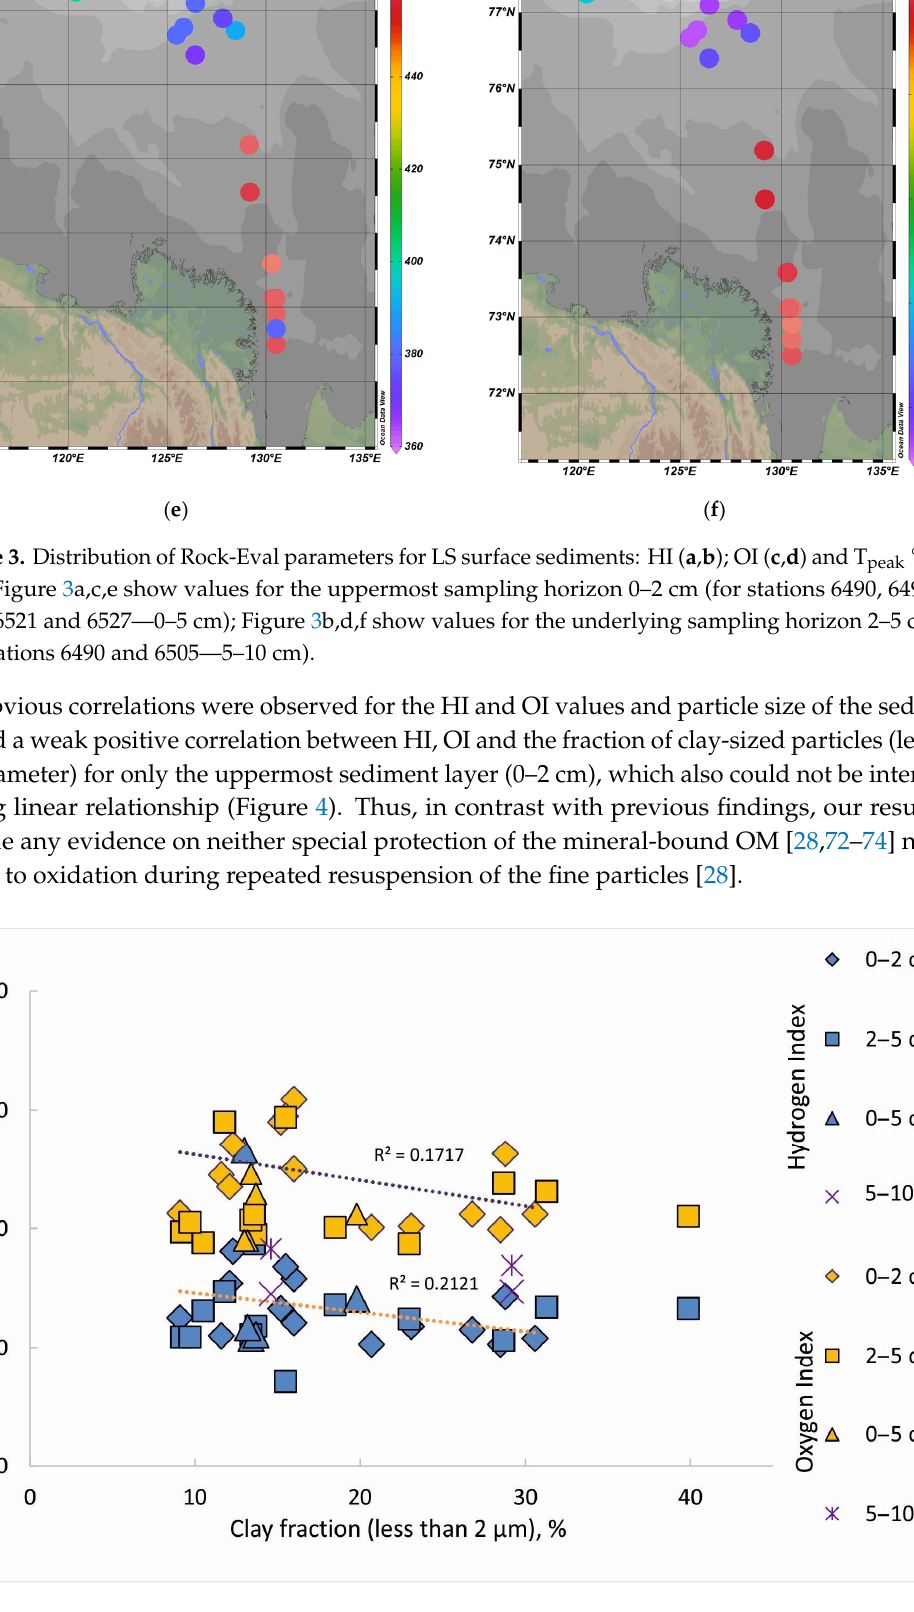
Figure 4. The relationship between HI and OI and the clay-sized fraction in LS surface sediments.